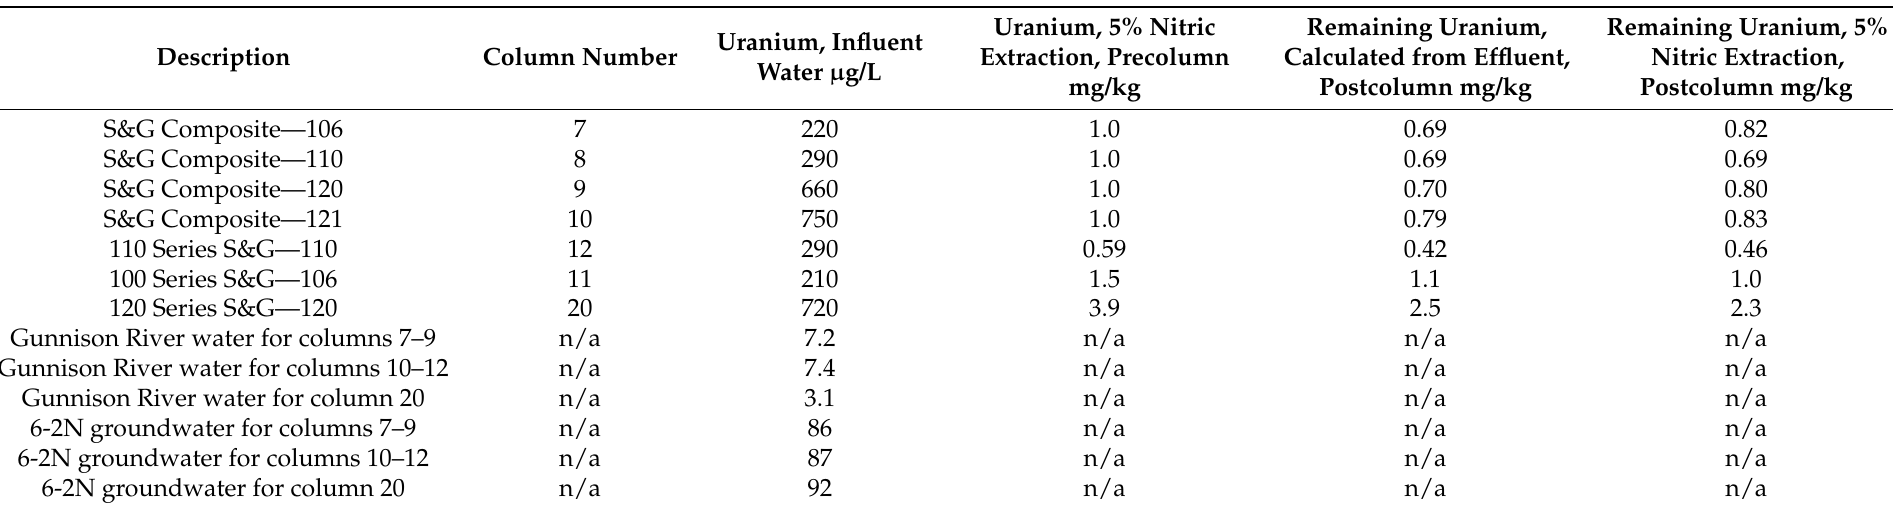
Table 3. Summary of saturated-zone columns with influent uranium concentrations and solid-phase uranium concentrations before and after completion of